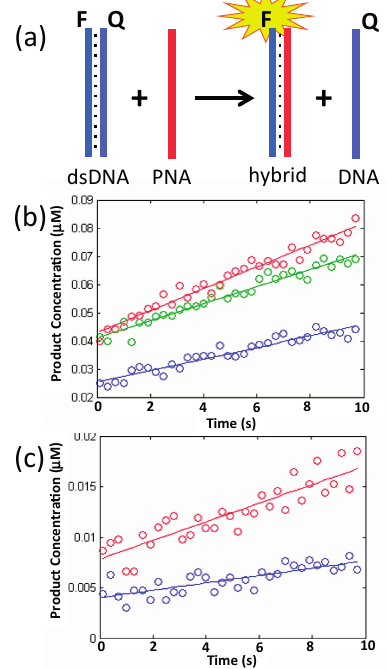
Figure 2. ( a ) Schematic representation of the fluorescence-based duplex invasion assay. PNA3K displaces the quencher-labeled DNA strand and turns on the fluorescent signal; ( b ) Graph of product concentration vs. time for PNA3K-mediated DNA duplex dissociation at the following starting concentrations: Blue, 0.5 μ M duplex and 1 μ M PNA3K; Green, dissociation at different MgCl 2 concentrations: Red, 6 mM MgCl 2 and Blue, 12.5 mM MgCl 2